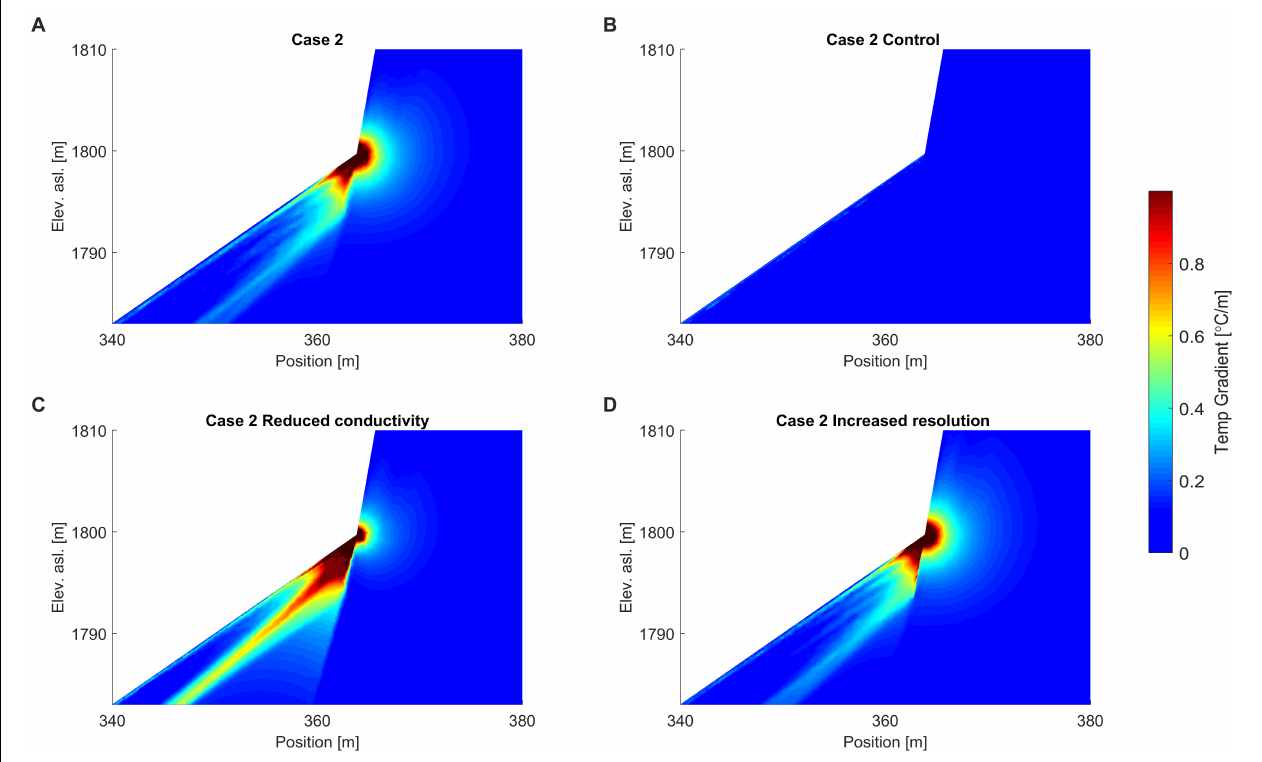
FIGURE 6 | Comparison of the magnitudes of thermal gradients over the 5-year period 2001–2005 for (A) Case 2 and (B) Case 2 Control simulations. In (C) and (D) we present the same 5-year average thermal gradients for Case 2 simulations with thermal conductivity in the talus reduced by a factor of five and increased resolution along the rock-talus boundary, respectively. Colors indicate magnitude of the temperatures